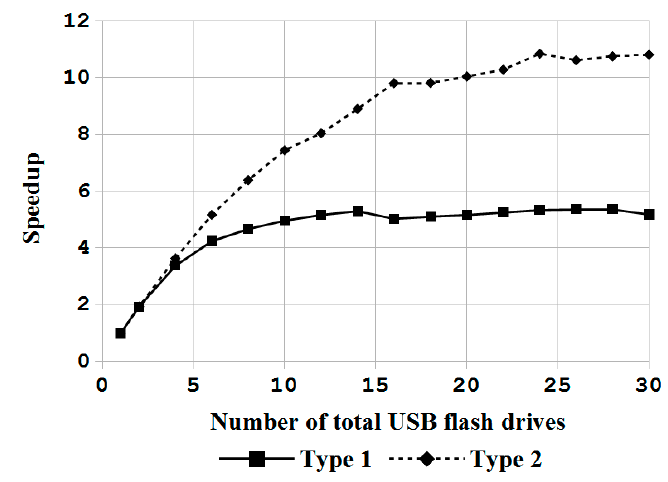
Figure 8. Speedup for deploying USB flash drives.